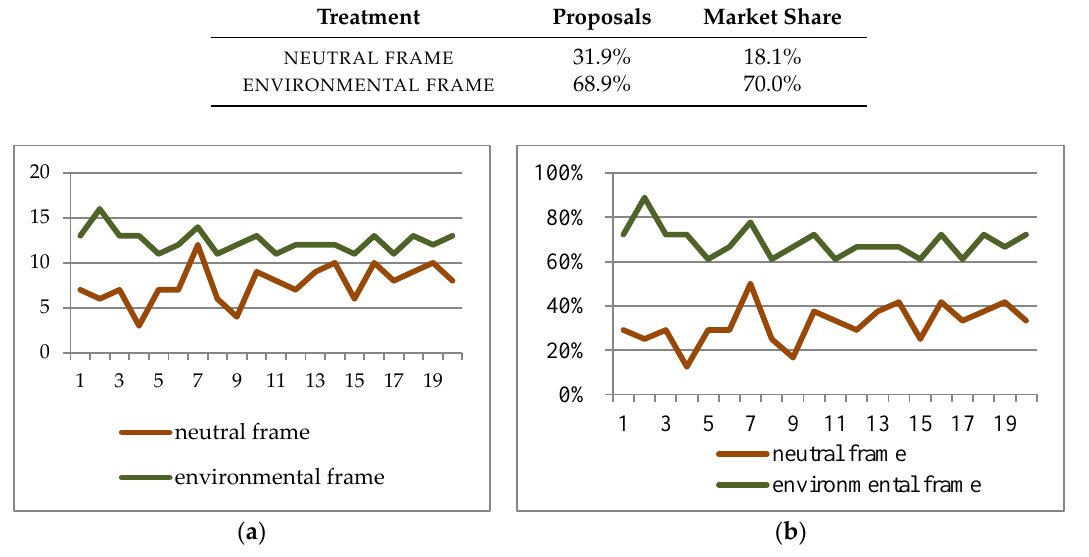
Figure 1. Announcements of green goods in NEUTRAL FRAME and ENVIRONMENTAL FRAME treatments (pooled market observations): ( a ) number of greens ( b ) share of green. Games 2018 , 9 , x FOR PEER REVIEW